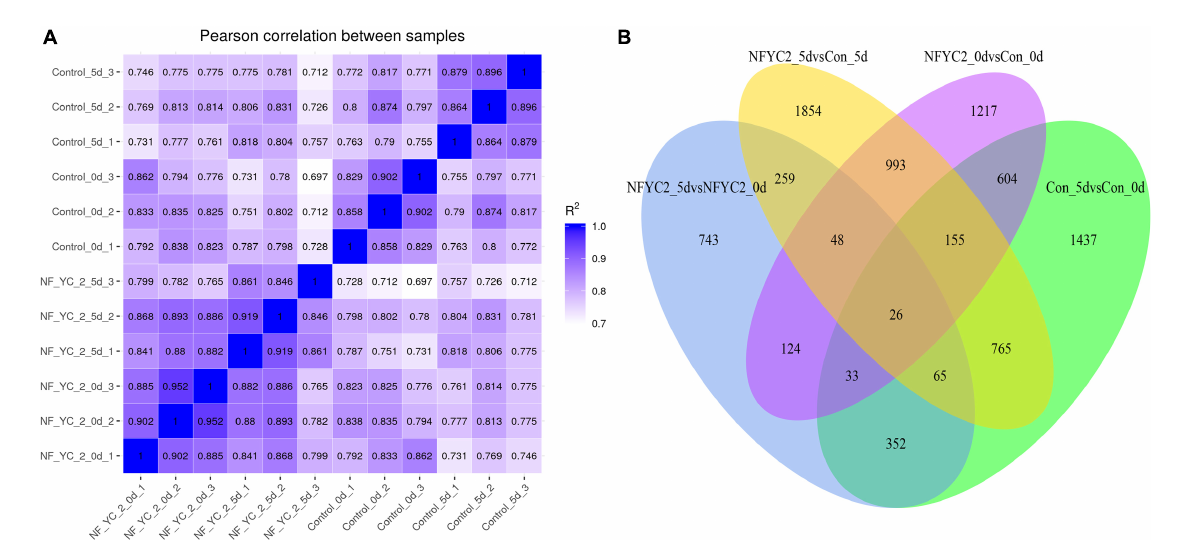
FIGURE5 (A) Sample correlation analysis of transcriptome data. (B) Venn diagram of the DEGs in comparisons in MsNF-YC2 overexpression and WT plants under normal and alkali stress